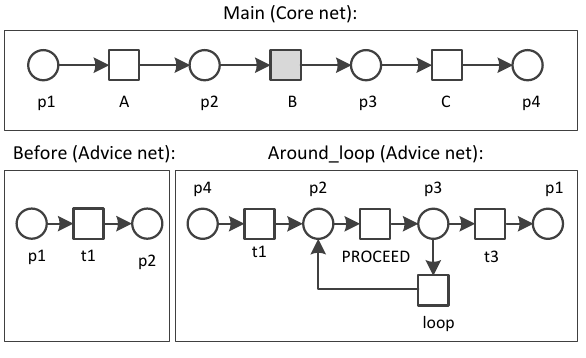
Figure 8. Aspect-Oriented nets defined for our sample scenario [6]